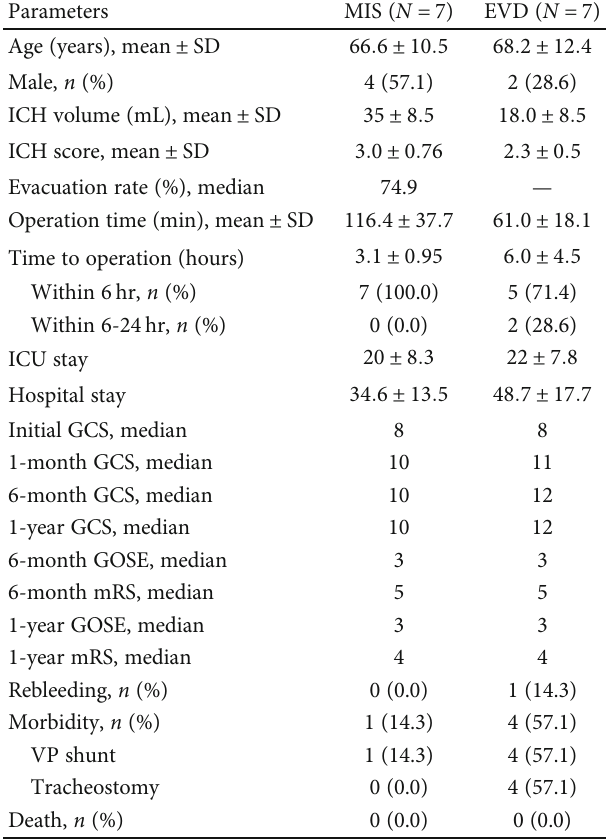
Table 1: Demographics, clinical characteristics, and